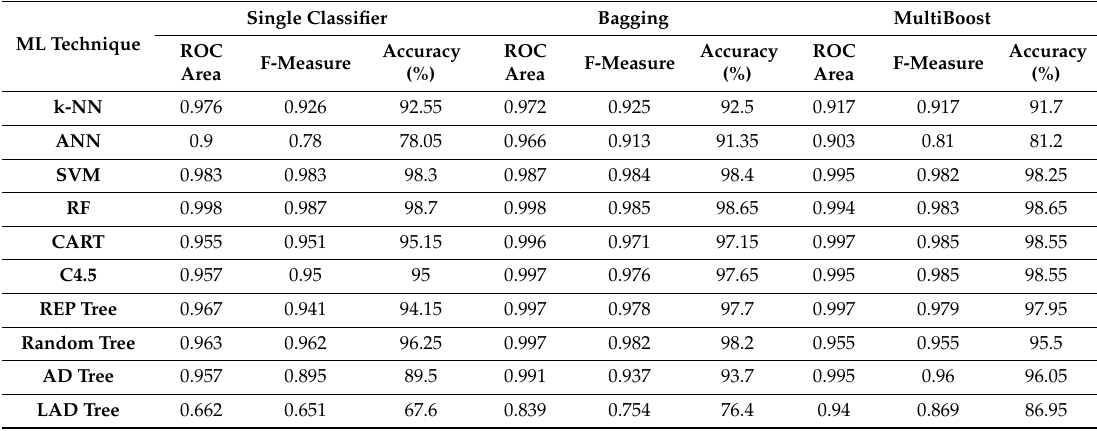
Table 1. Performance of classification method (Single Classifier, Bagging, MultiBoost).